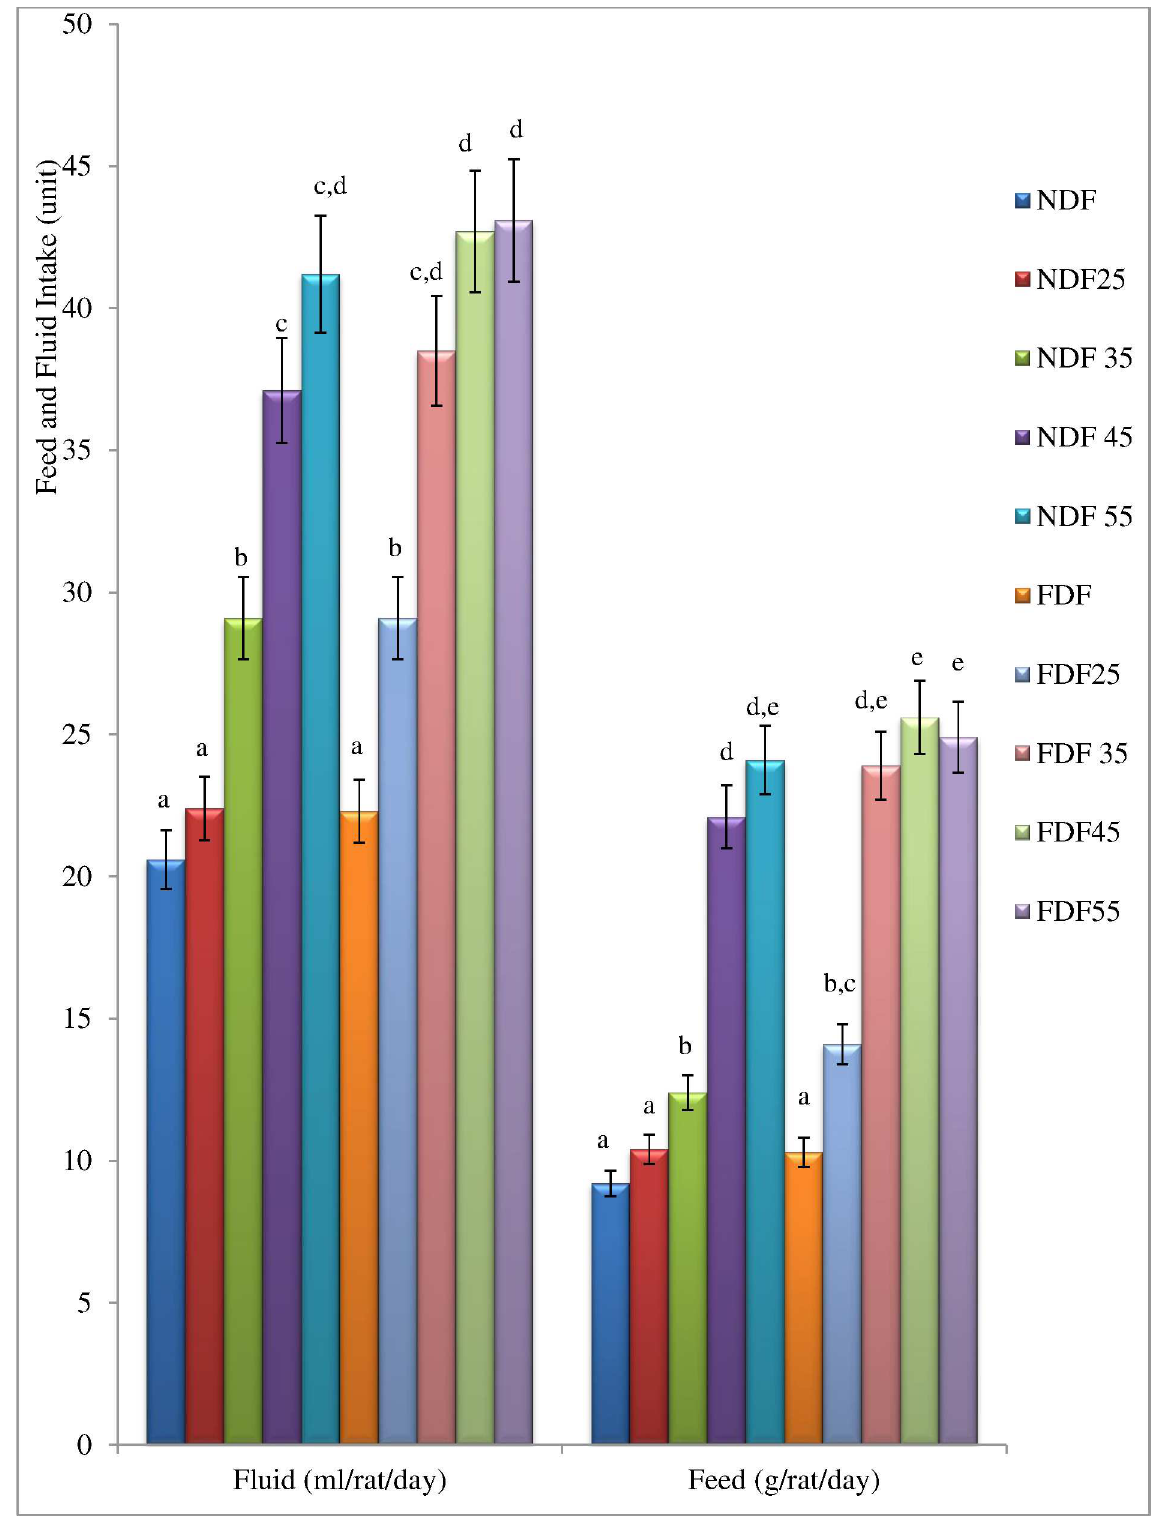
Fig 1. Mean Fluid Intake and Feed Intake of each Animal in the Groups per Day during the Experimental Period. Data are presented as mean ± SD of 6–8 animalsper group. Bars with different superscript indicate significantdifference (P < 0.05).